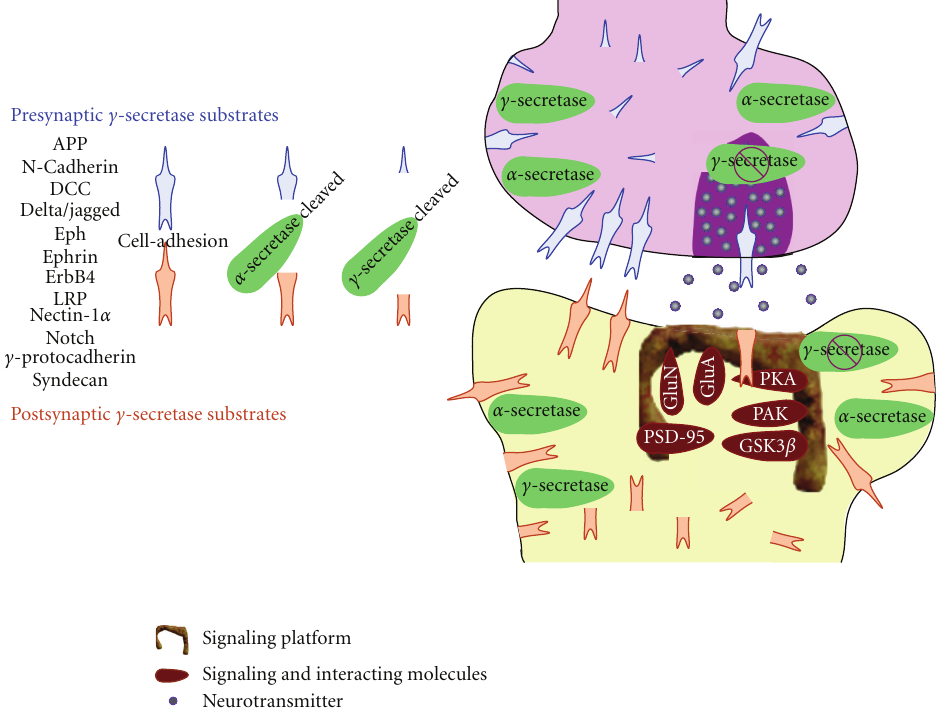
Figure 1: Schematic representation of PS-dependent processing of substrates and their role in synaptic function. Several γ -secretase substrates are located at the synapse where they influence the function of other synaptic proteins. Lack of γ -secretase-dependent cleavage of substrates could perturb presynaptic release and postsynaptic function of glutamate receptor-mediated events (NMDA-GluN and AMPA- GluA receptors). Synaptic contact could also be modulated through cell-adhesion properties of several γ -secretase substrates. Ine ffi cient processing of these substrates will lead to sustained activation of signaling cascades capable of altering the postsynaptic morphology. How FAD-linked mutations in PS influence these processes and contribute to the disease progression has not been fully